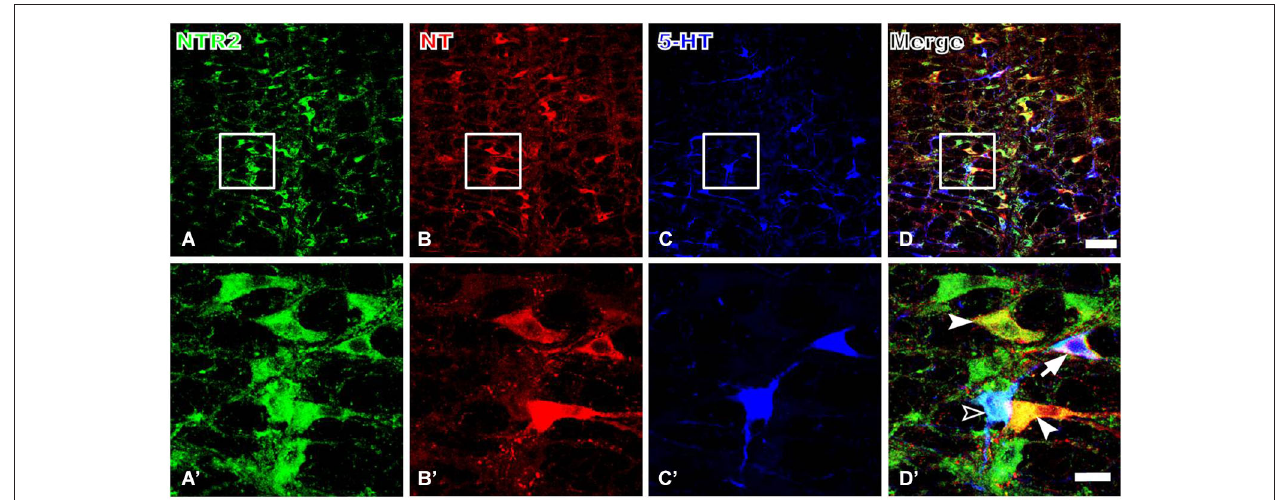
indicate NTR2/NT double-labeled neurons; the unfilled arrowheads indicate NTR2/5-HT double-labeled neurons; and the arrows indicate NTR2/NT/5-HT